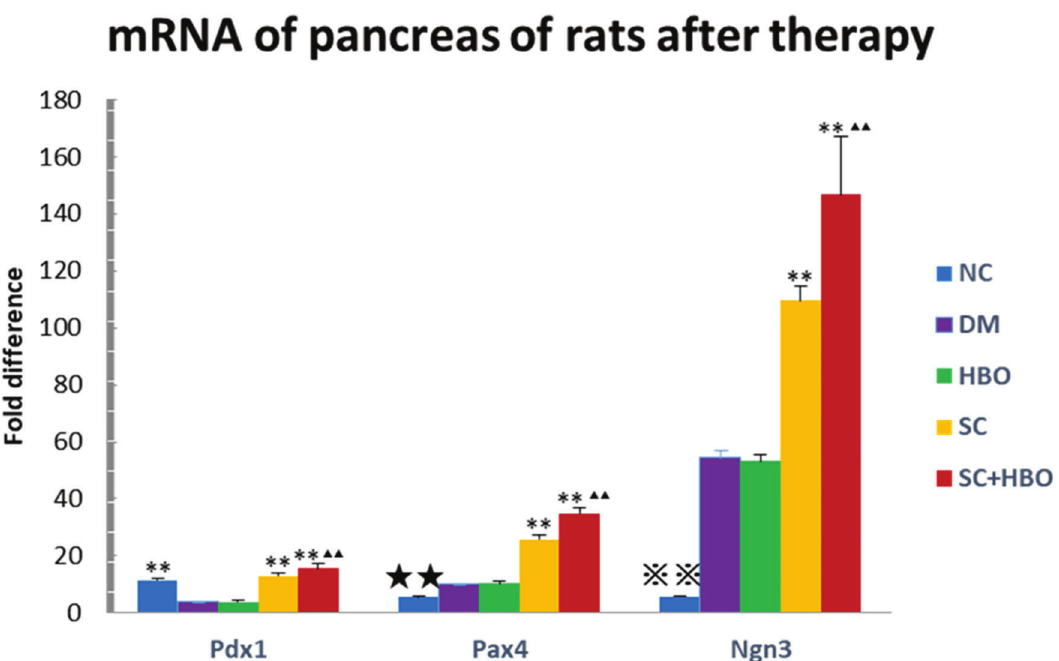
Figure 6 - Expression of Pdx1 , Pax4 , and Ngn3 mRNAs in the pancreas by PCR after 6 weeks of therapy. Gene expression of the SC + HBO group and the SC group was higher than that of the DM group; and the expression of the SC + HBO group was higher than that of the SC group. ** p o 0.01 vs DM group; mm p o 0.01 vs SC group; :: p o 0.01 vs each of the other four groups; %% p o 0.01 vs either SC group or SC + HBO